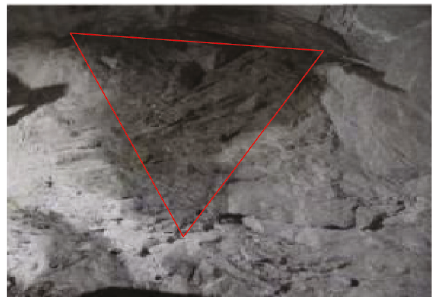
Figure 27: Destruction of the deep and large structural plane in K0 +545m of the tailrace surge chamber pilot